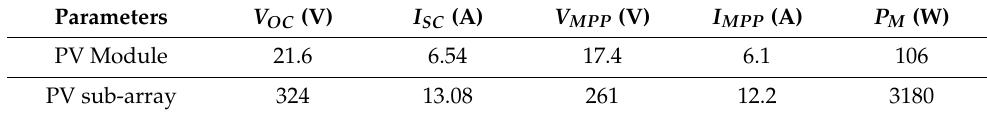
Figure 1. Main electrical specifications of the PV module and sub-array at STC. Table 1. Main electrical specifications of the PV module and PV sub-array at STC.